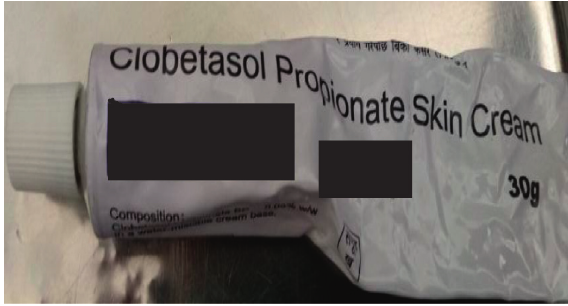
Figure 2: Very potent topical steroid used by the